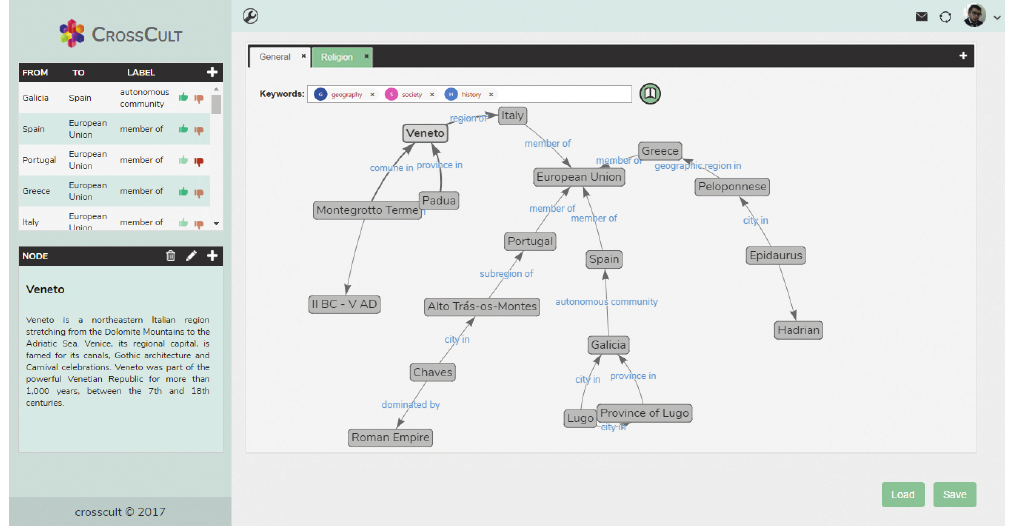
Figure 9. Edition of topics and